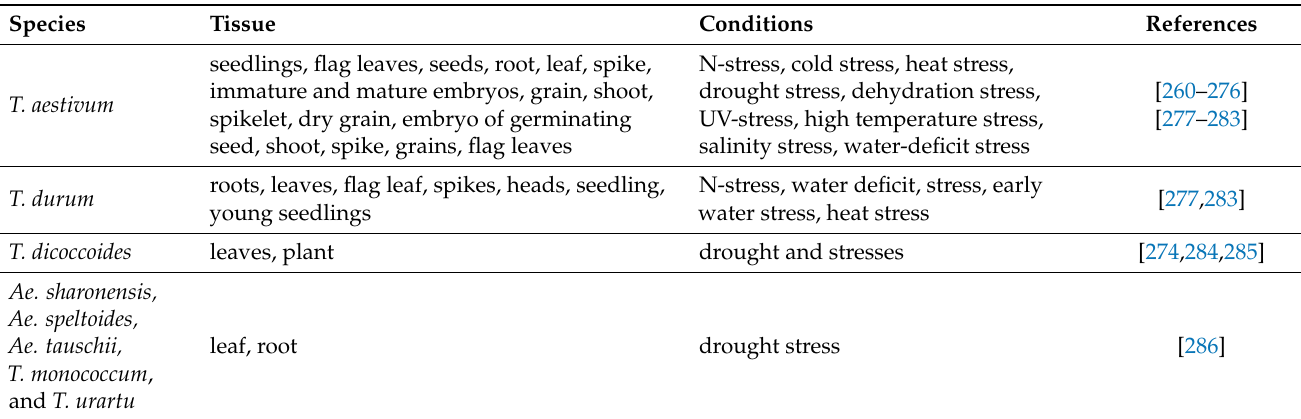
Table 6. The brief of identified microRNAs in wheat and some of its